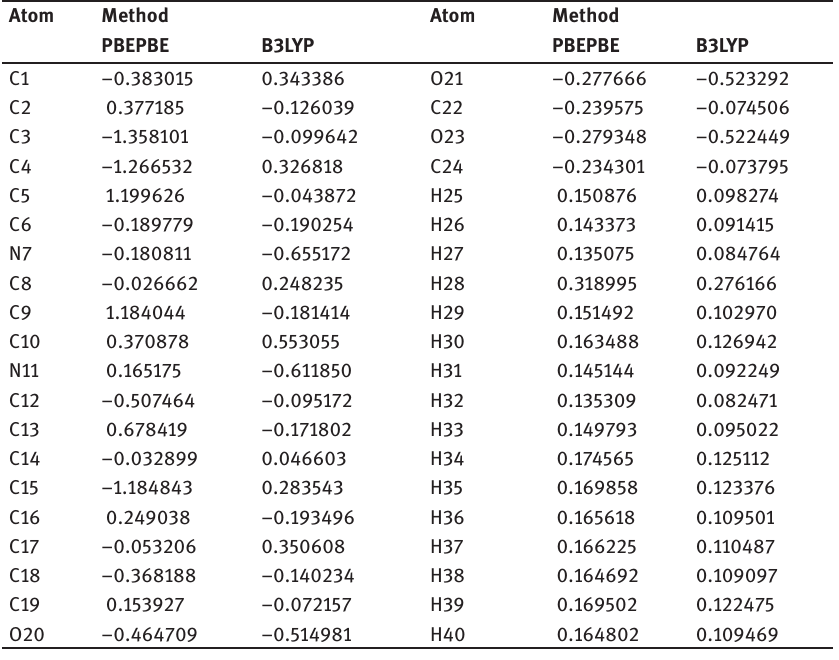
Table 1 : Mulliken charges of MIMIM calculated by PBEPBE and B3LYP methods. Atom Method